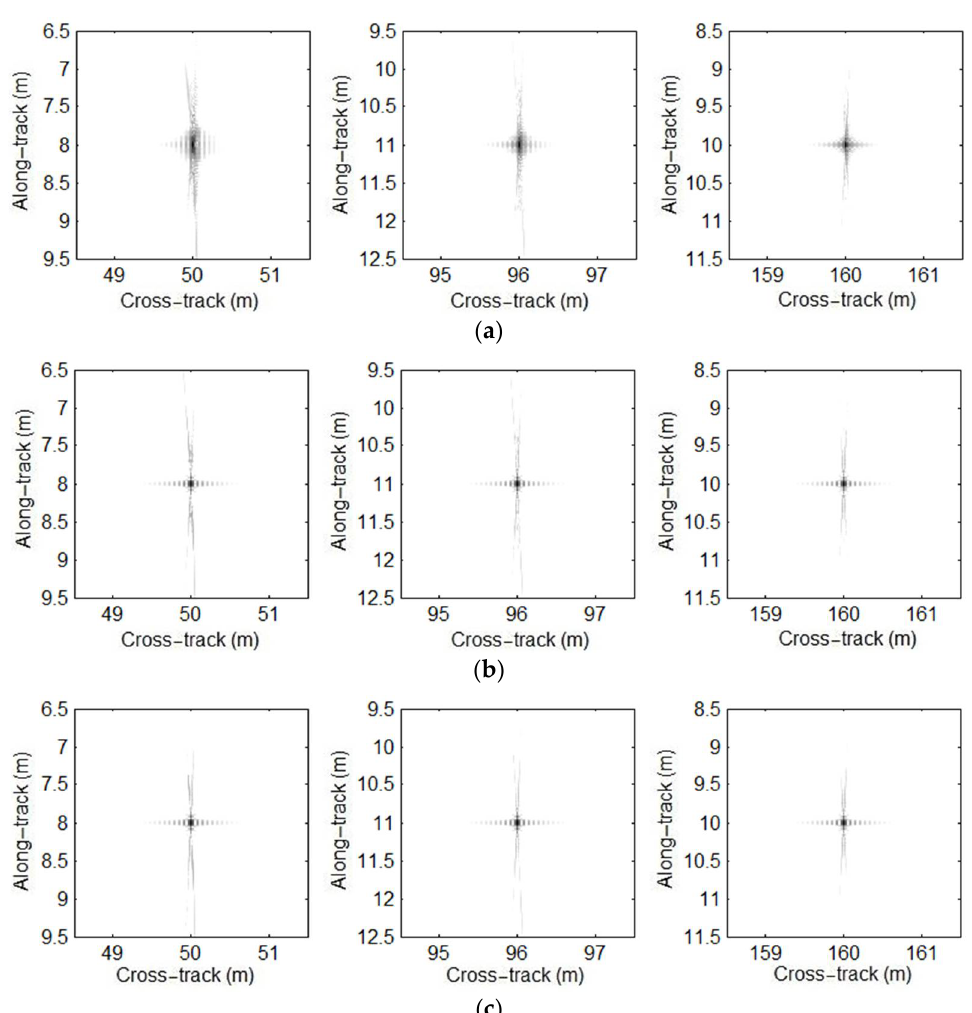
Figure 16. Imaging results with the case of a wide-bandwidth signal. ( a ) Traditional method; ( b ) presented method; ( c ) BP algorithm.